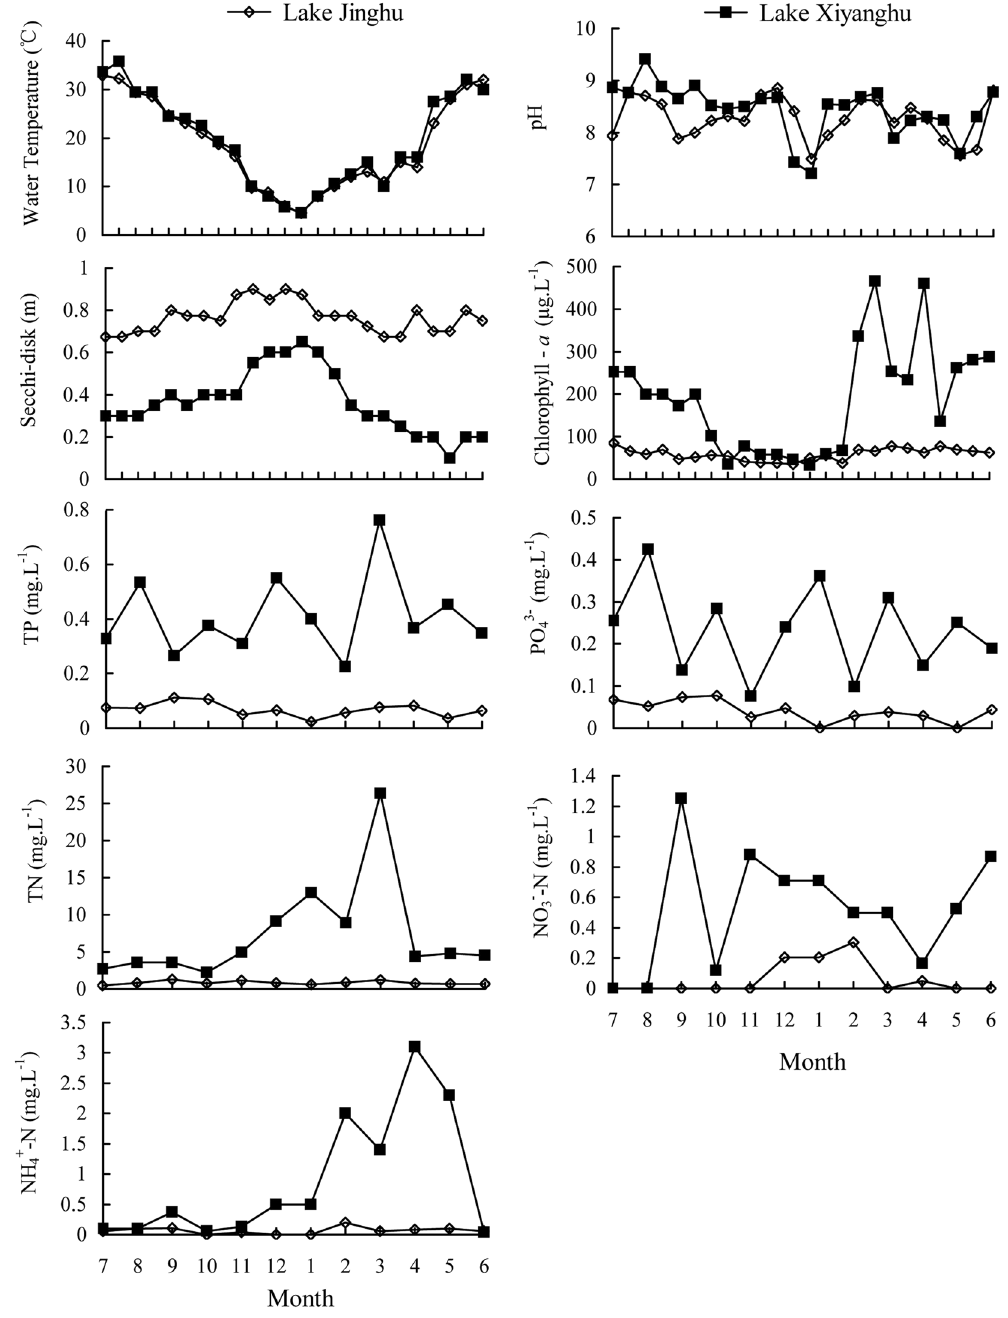
Figure 1. Annual dynamics of physico-chemical factors in Lake Jinghu and Lake